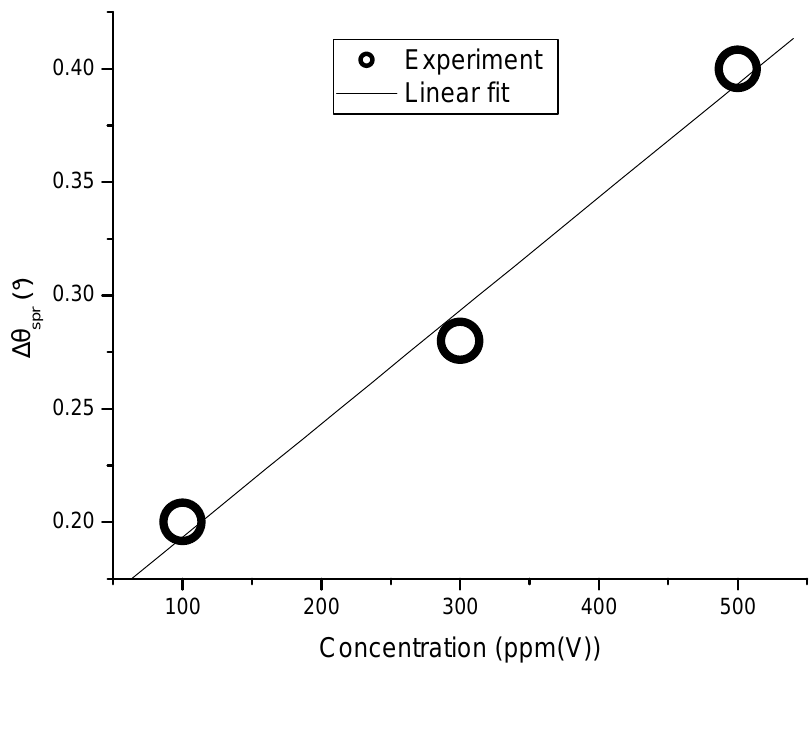
Figure 3. Sensor response measured by means of the SPR angle shift versus concentration. An approximately linear relationship can be